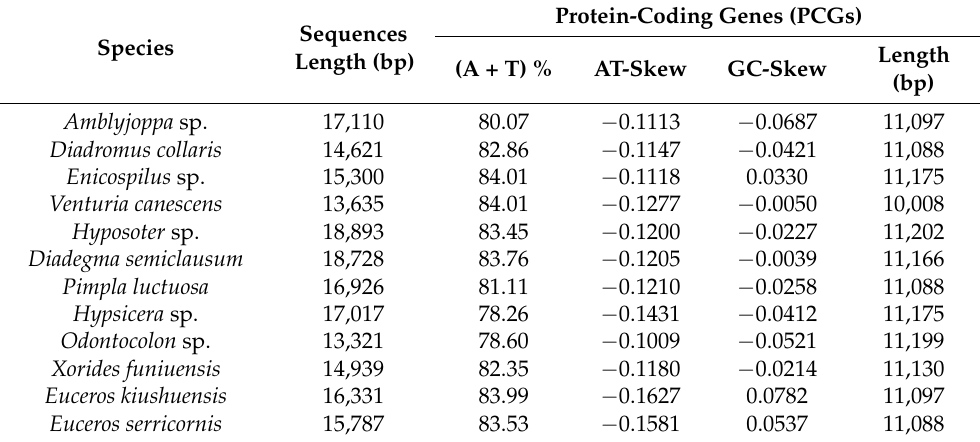
Table 2. Base composition of the mitochondrial genomes in